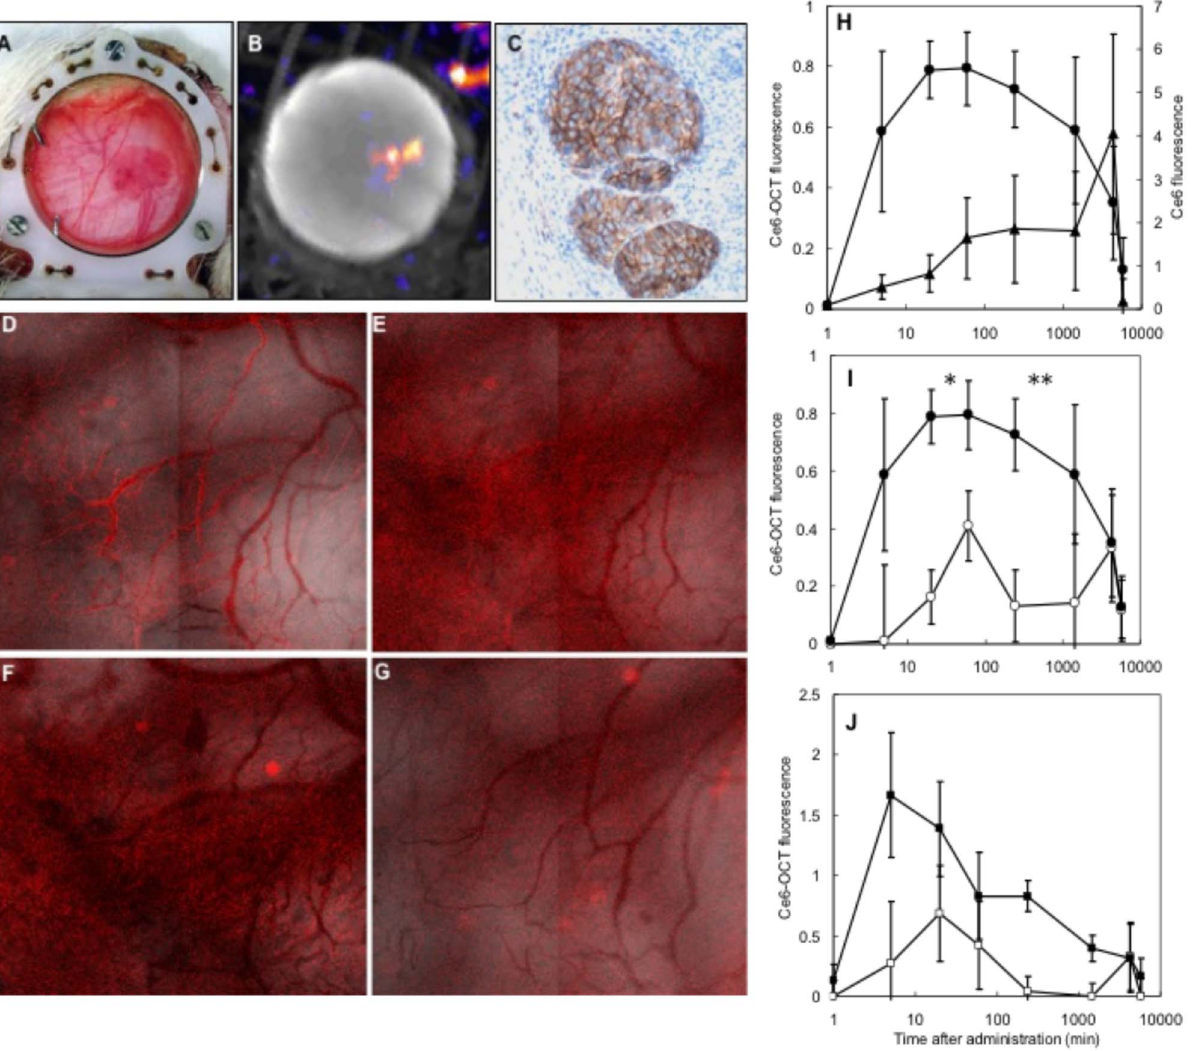
Figure 5. (A) AR42J tumor in the skin-fold observation chamber; (B) Corresponding OctreoScan-SPECT/CT fusion image; (C) Immunohistochemical sst 2 stain; (D–G) Conjugate 1 fluorescence/white light transmission fusion images 5 min, 1 h, 4 h and 24 h after conjugate administration respectively; (H) In-vivo fluorescence pharmacokinetics of Ce6 ( m ) (n=3) and conjugate 1 ( observation chamber; (I) In-vivo fluorescence pharmacokinetics of conjugate 1 in tumor tissue with ( # ) and without ( Octreotide; (J) In-vivo fluorescence pharmacokinetics of conjugate 1 in the tumor vasculature with ( % ) and without ( & ) the addition of free Octreotide. There is a statistically significant difference between the fluorescence in tumor tissue between the blocked and the unblocked groups 20 min (p=0.04) and 20 min (p=0.004) after administration